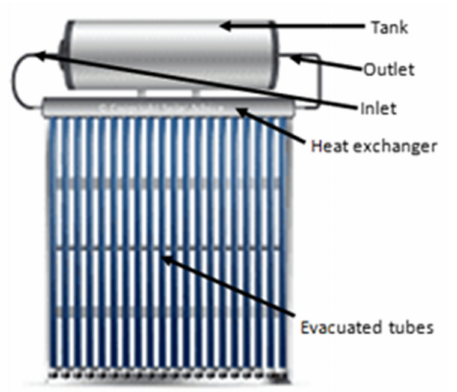
Figure 2. Evacuated tube